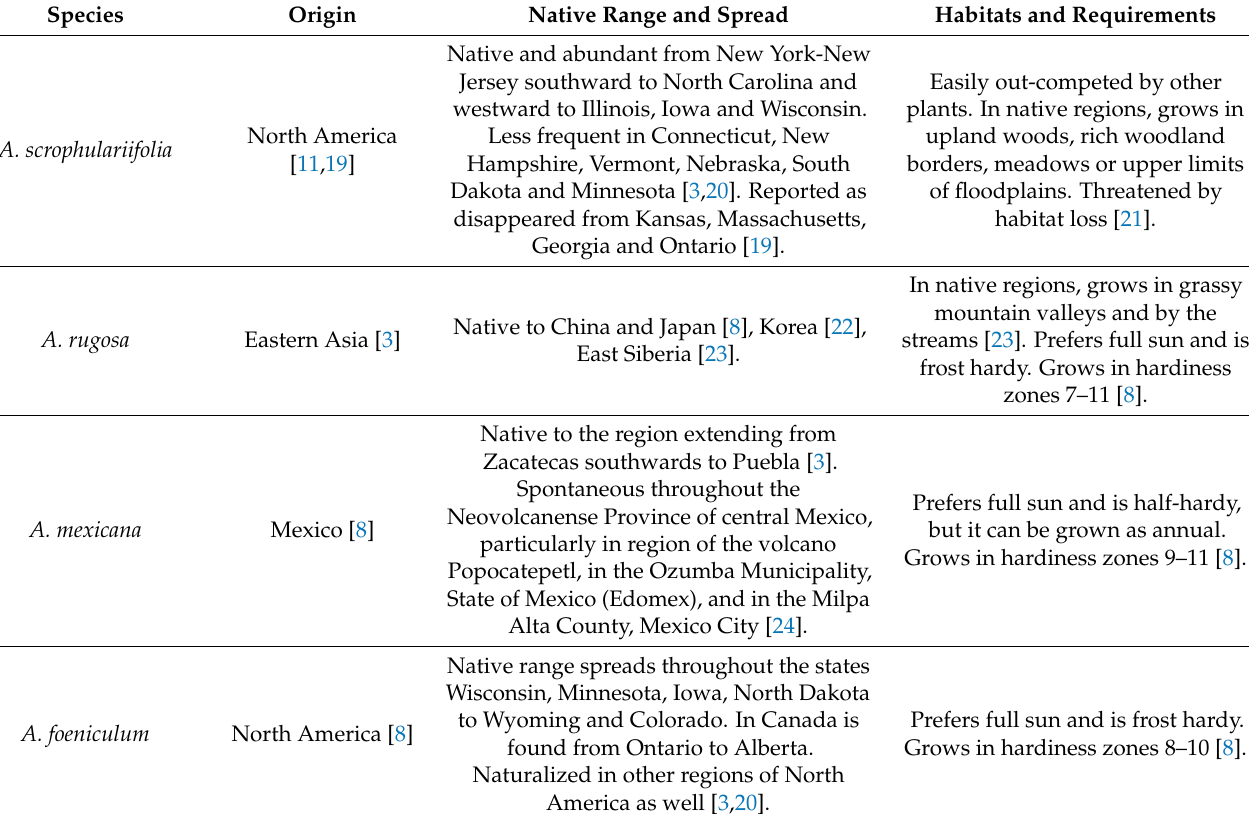
Table 1. Ecology of the Agastache sp.